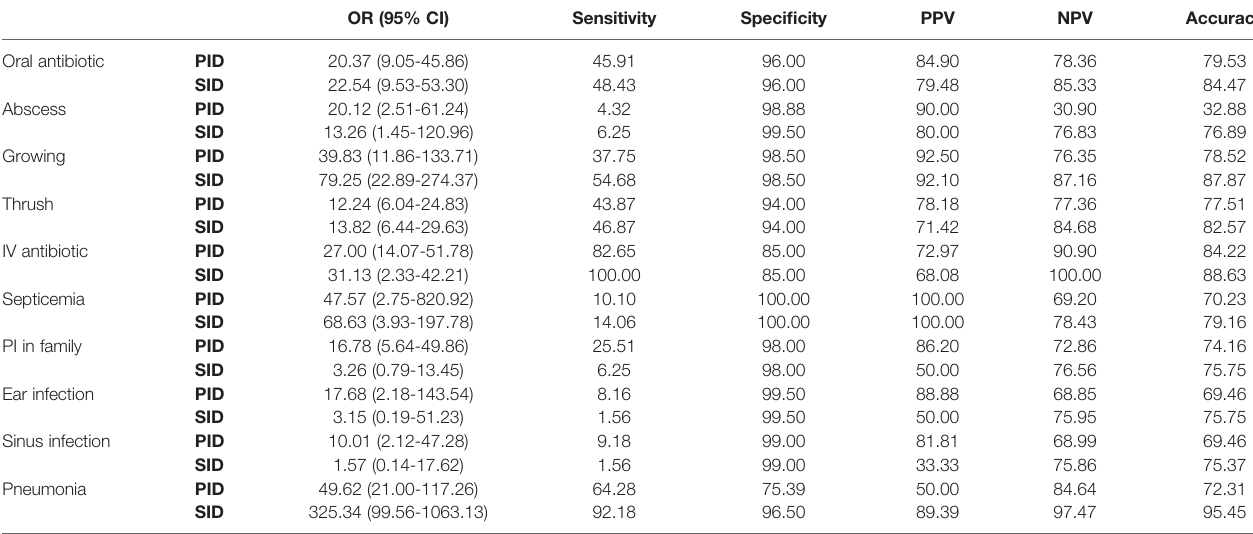
TABLE 3 | OR, sensitivity and speci fi city of the 10 warning signs developed by